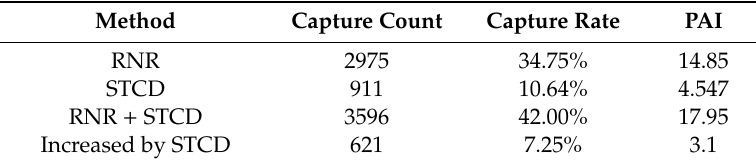
Table 2. Accuracy of crime prediction based on RNR and